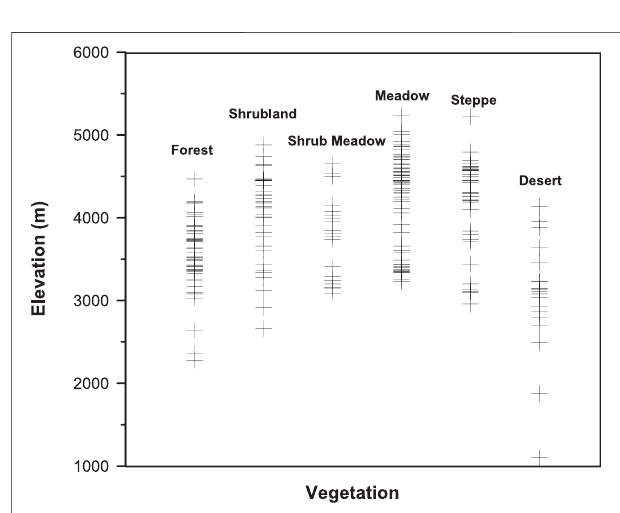
FIGURE 2 | Elevation at which the surface sample sites are